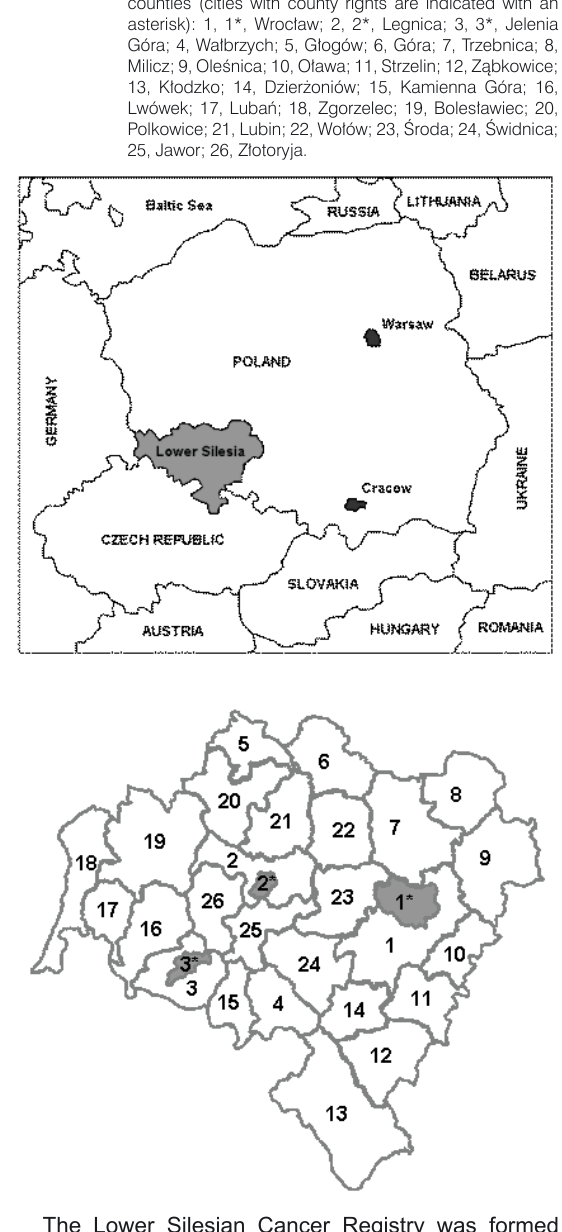
Figure 1. Map of the Lower Silesian province and its division into counties (cities with county rights are indicated with an asterisk): 1, 1*, Wrocław; 2, 2*, Legnica; 3, 3*, Jelenia Góra; 4, Wałbrzych; 5, Głogów; 6, Góra; 7, Trzebnica;